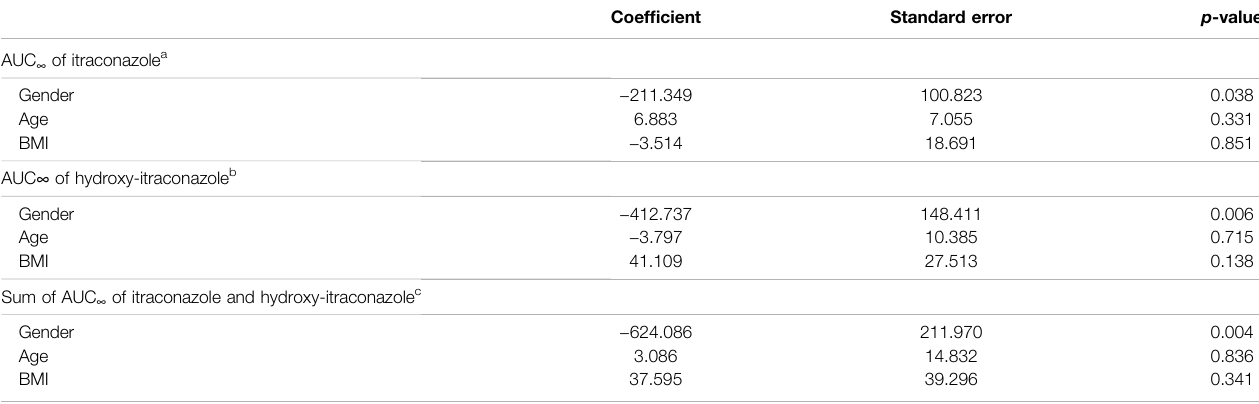
TABLE 2 | Multiple linear regression analysis for AUC ∞ of itraconazole (ITR) and hydroxy-itraconazole (HITR), as well as the sum of ITR and HITR obtained from non- compartmental analysis as a dependent (target) variable with age, gender, and body mass index as independent variables.